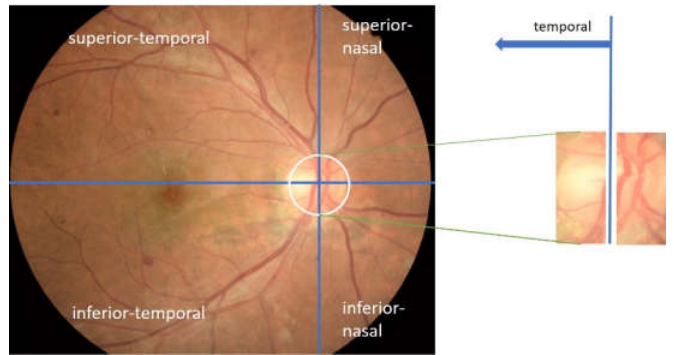
Figure 4. Temporal direction viewed from the appearance of blood vessels in the optic disc.